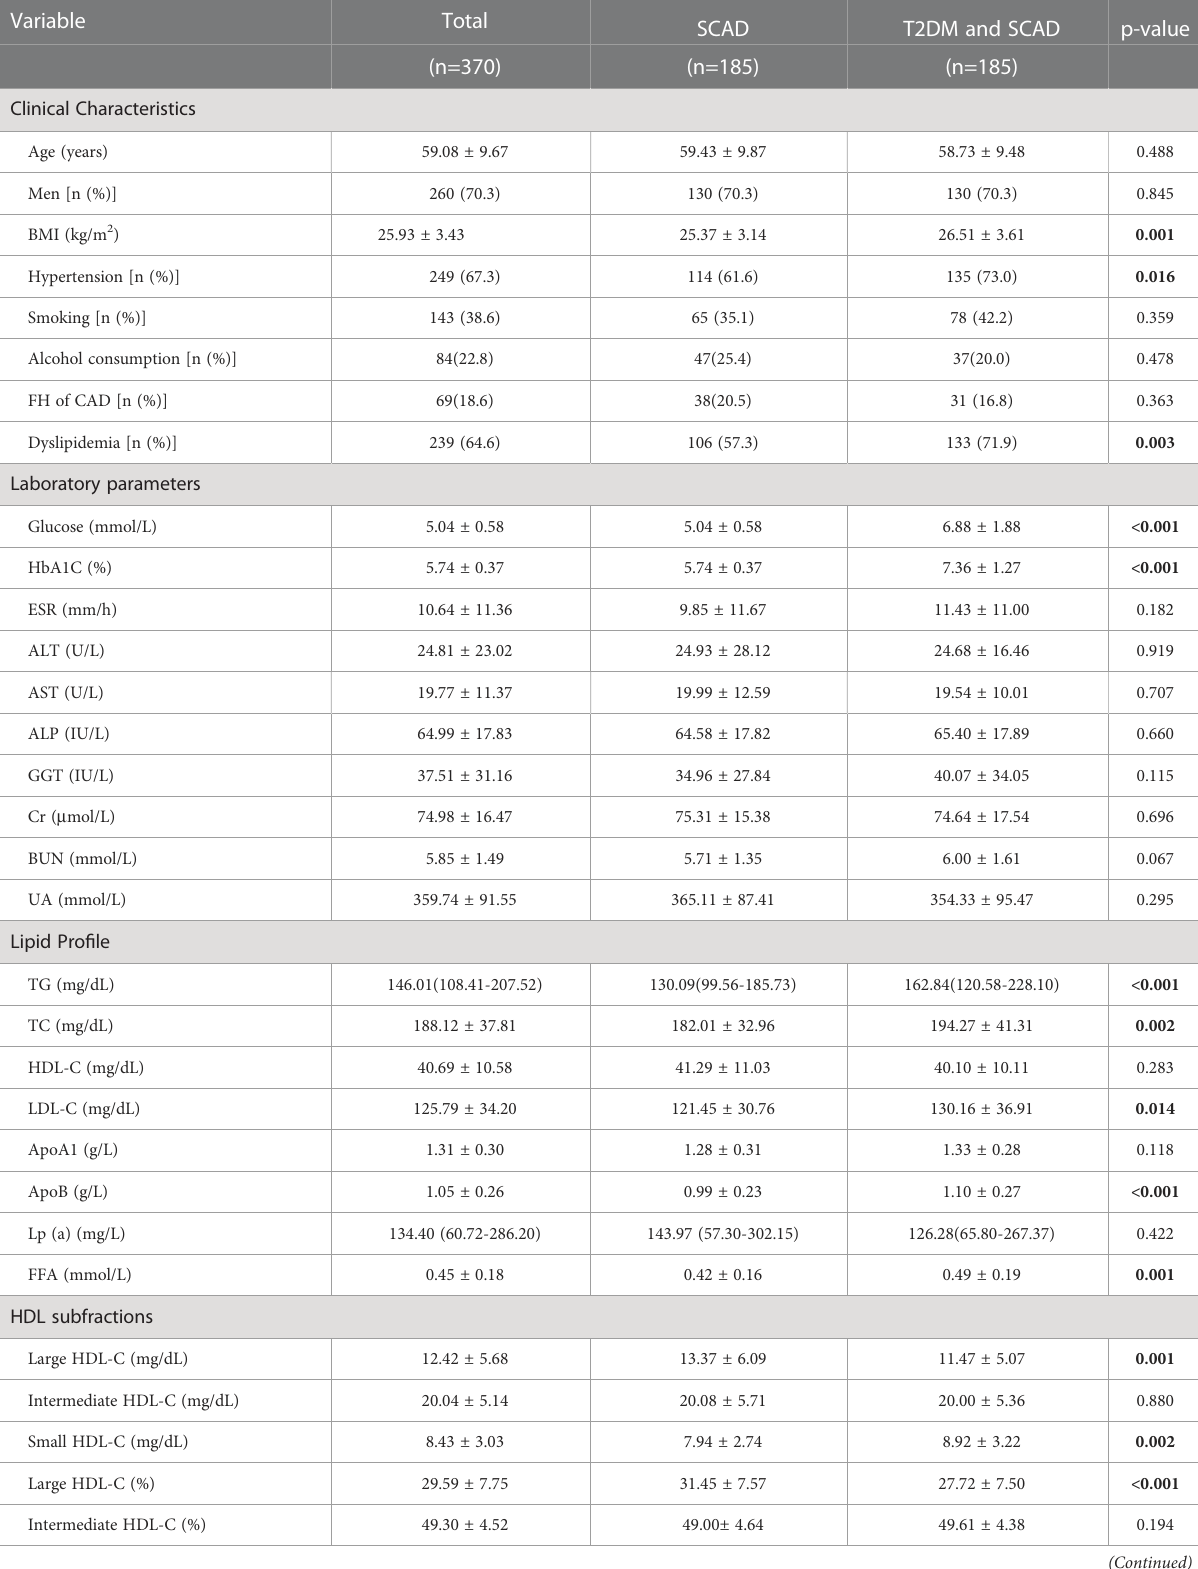
TABLE 1 Baseline characteristics in this